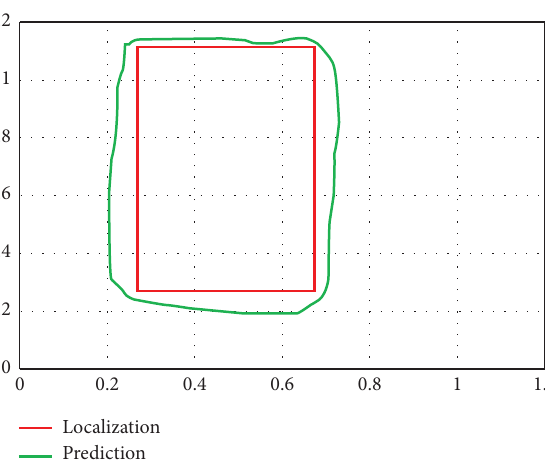
Figure 13: ICP indoor positioning experiment results based on line segment characteristics when moving along a rectangular